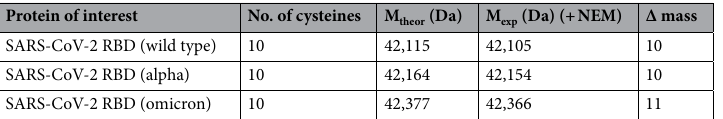
Protein of interest